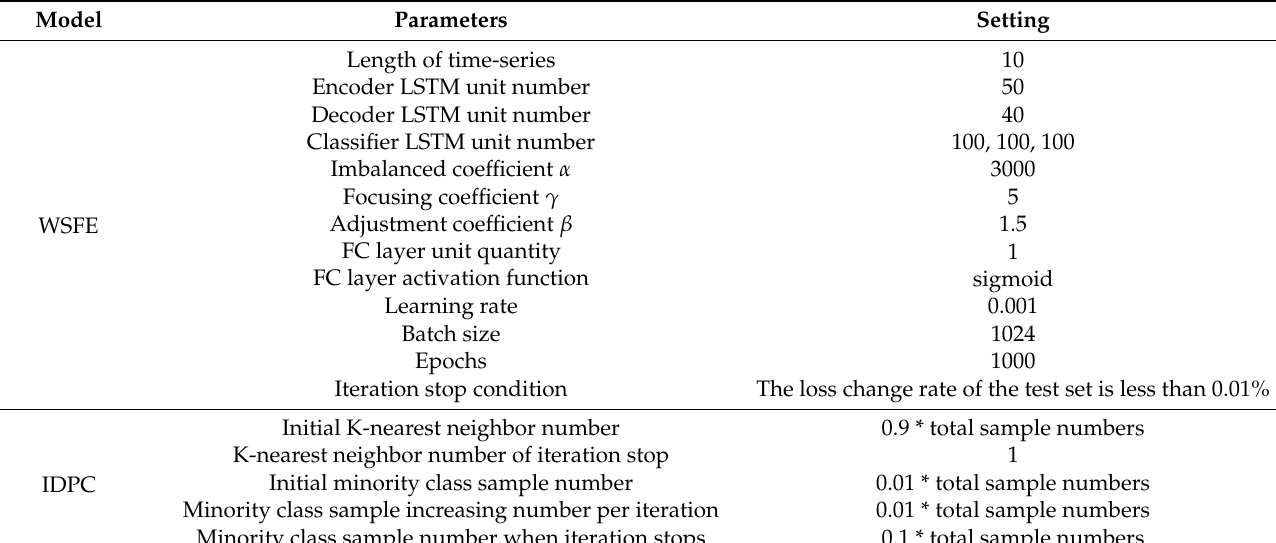
Table 3. Hyperparameters.